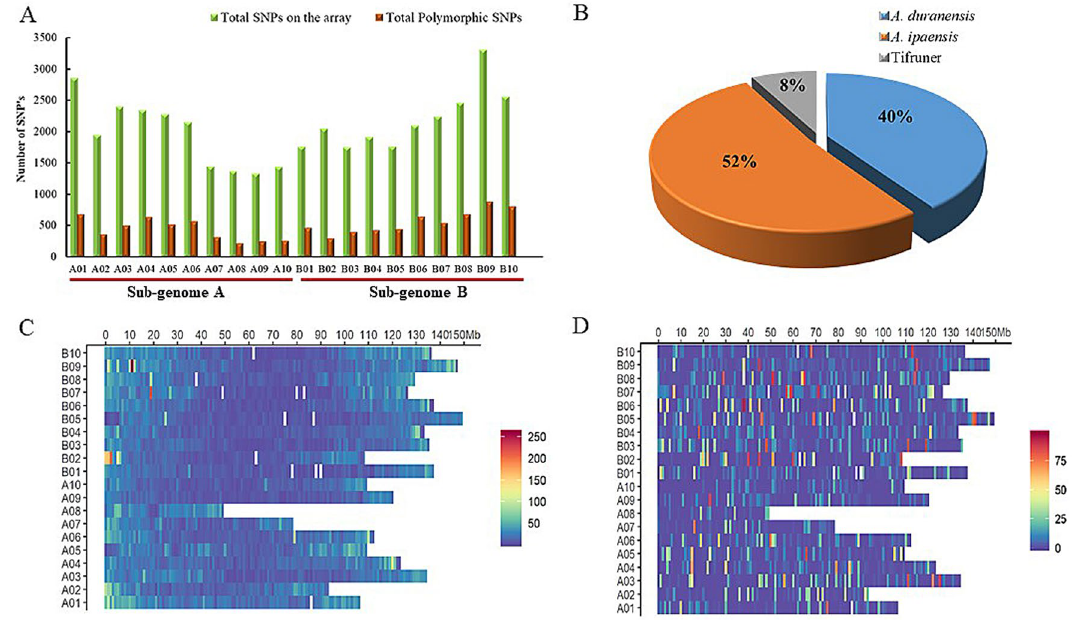
Figure 1. ( A ) Pseudomolecule-wise SNP distribution on the array and the distribution of polymorphic SNPs in the ‘Korean Set’ of genotypes, ( B ) Species-wise representation of SNPs (%), ( C ) Heat map of genome-wide distribution SNP calling pattern and genome density, ( D ) Heterozygosity distribution of genotype used for analysis (deep blue: A Homo; mid Blue: Hetero; light Blue: B Homo; white: